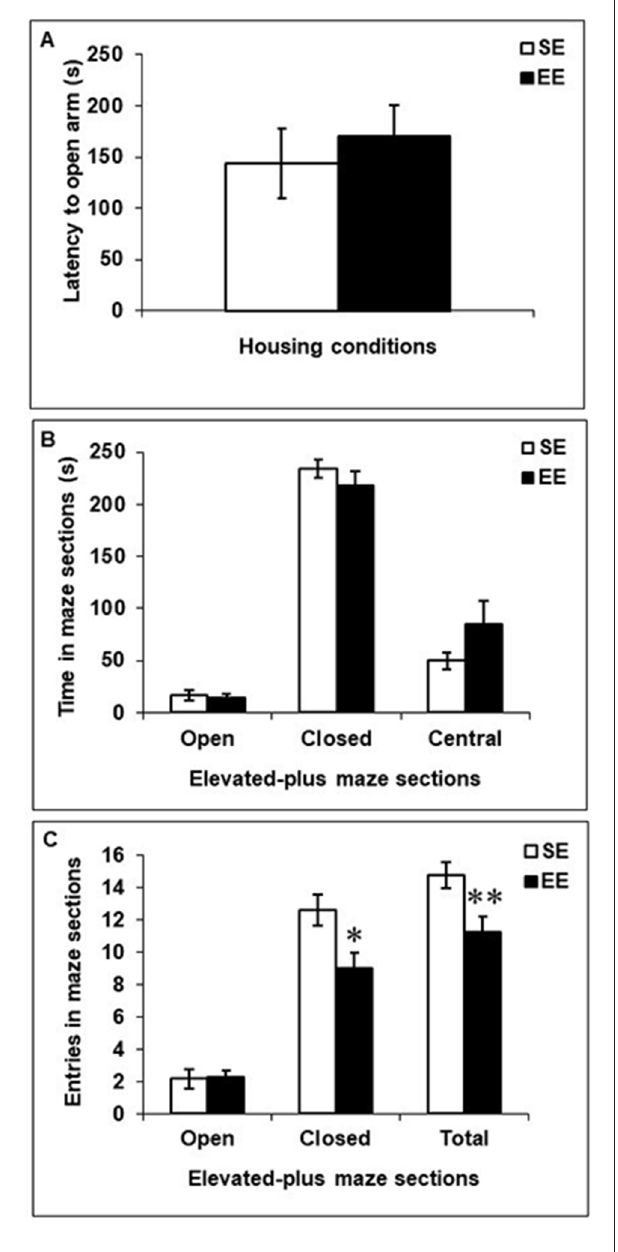
FIGURE 3 | Anxiety-like behaviors in the elevated-plus maze in mice that had been housed for 6 weeks in a SE or an EE. (A,B) Latency to enter an open arm as well as time spent in open arms, closed arms, and the central platform of the maze were comparable between EE and SE mice. (C) Mice housed in EE made fewer entries in the closed arms of the maze and fewer transitions between the different arms of the maze compared to SE mice. ∗ p < 0.05 and ∗∗ p < 0.01 relative to mice housed in SE. Data represents means ± SEM (mice house in SE: n = 12; mice housed in EE: n =